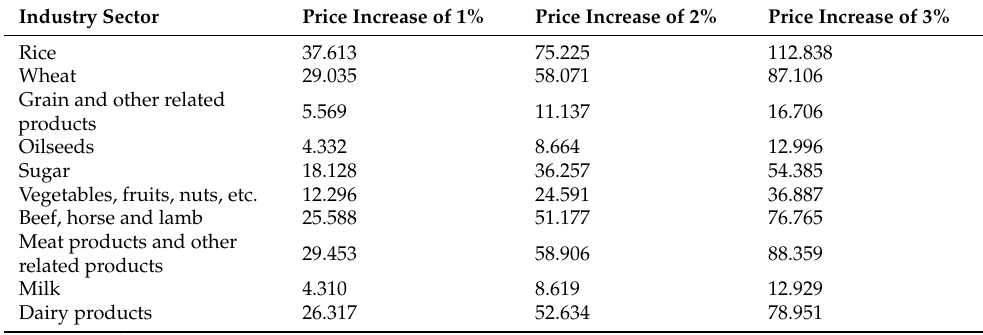
Table 7. Impact of price changes on the import volume of different agricultural